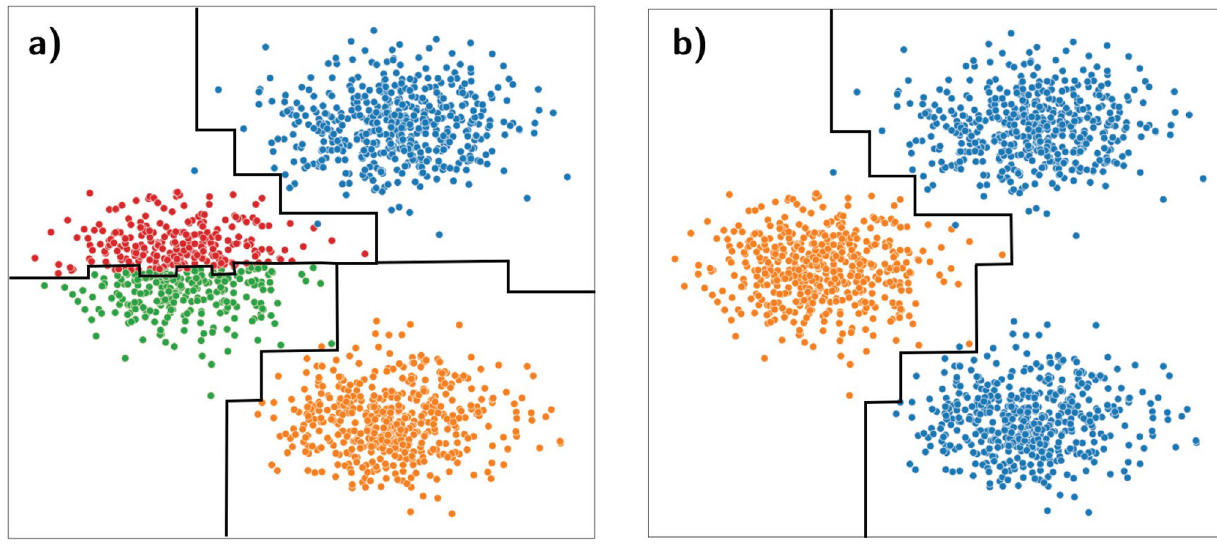
Fig 1. Overclustering (n Cluster = 4) a) versus underclustering (n Cluster = 2) b). The ground truth has 3 distinct clusters. The black lines represent the decision boundaries obtained via a random forest classifier trained on the clustering labels. a) Using over clustered labels for fitting a classifier leads to overfitted decision boundaries that separate regions of high density (red ang green region separation). b) For underclustered labels, the classifier groups together two clusters separated by a region of low density.